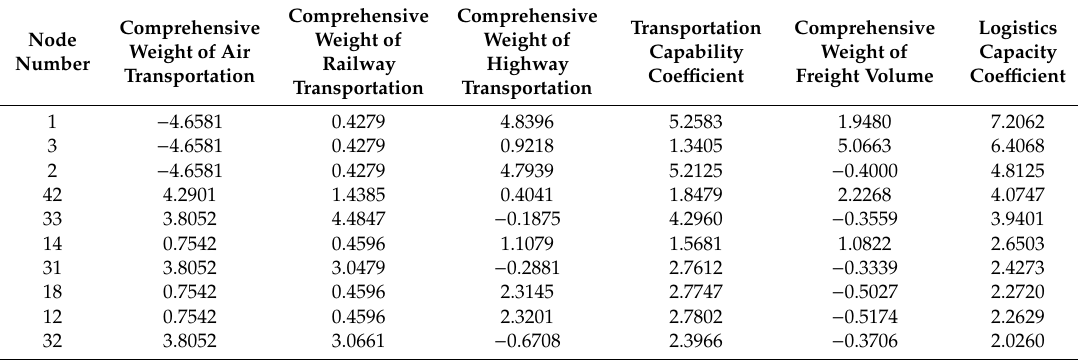
Table 11. Calculation and sorting of the logistics capacity coe ffi